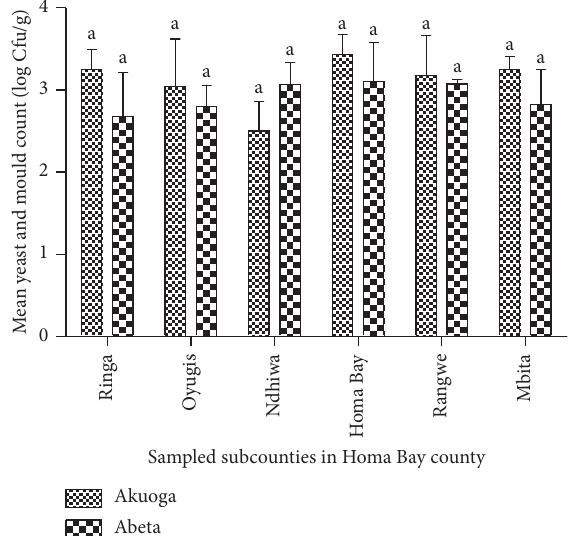
Figure 2: Yeast and mould count in A kuoga and Abeta types of processed cassava. Figures with same letter are not significantly different.